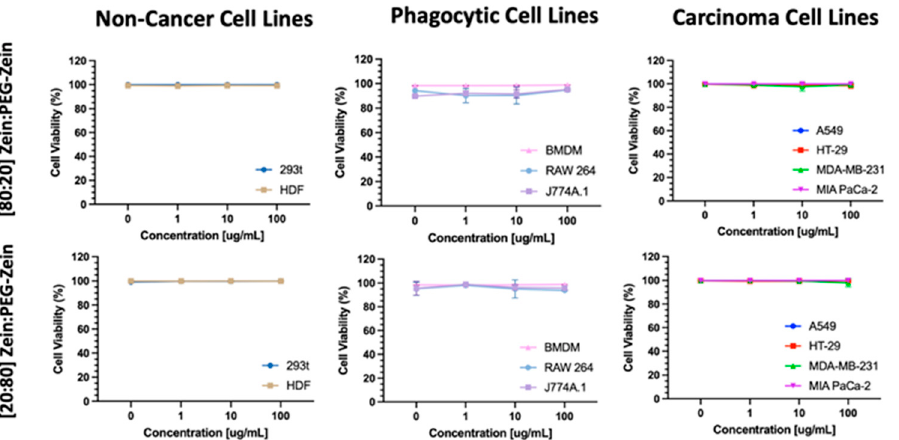
Figure 8. Cell viability at 72 h after [80:20] or [20:80] Zein:PEG-Zein NPs incubation at 0, 1, 10, or 100 µg/mL for non-cancer (293t and HDF), phagocytic (BMDM, RAW 264 and J774A.1) and carcinoma (A549, HT-29, MDA-MB-231, and MIA PaCa-2) cell lines.